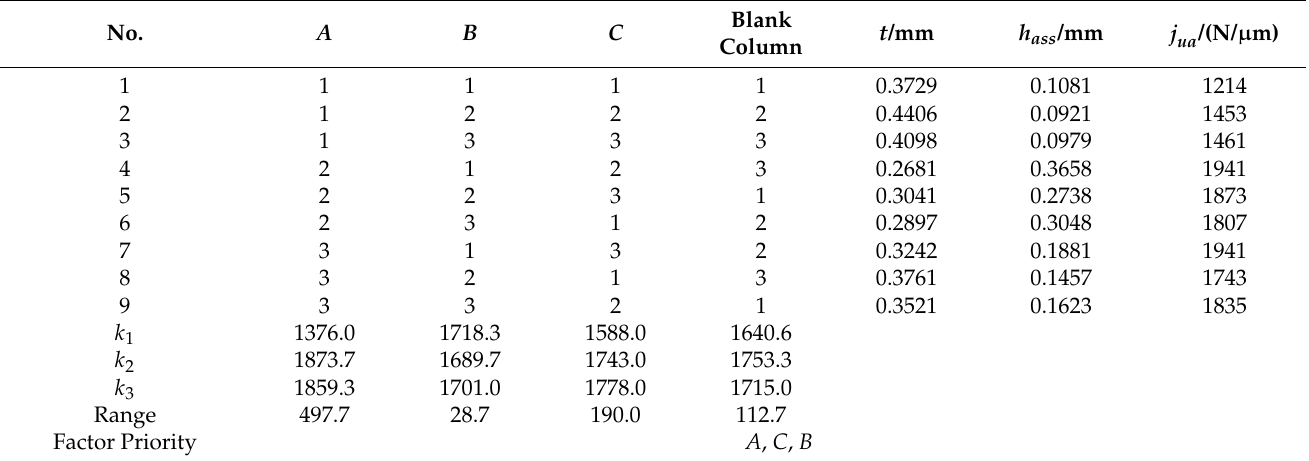
Table 3. Orthogonal experiment